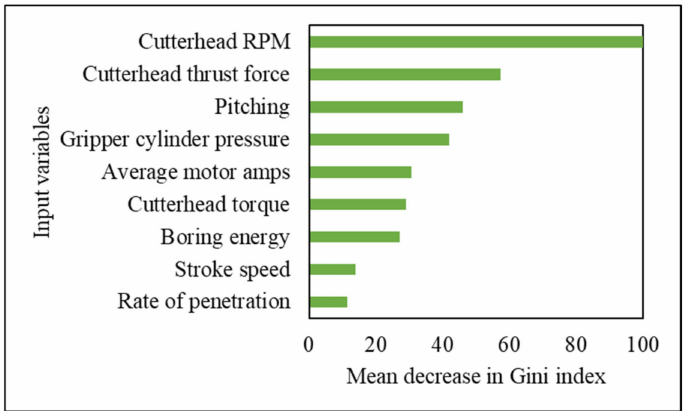
Figure 9. Sensitivity level of rock mass class to input variables based on mean decrease in Gini index expressed a percentage of the maximum Gini